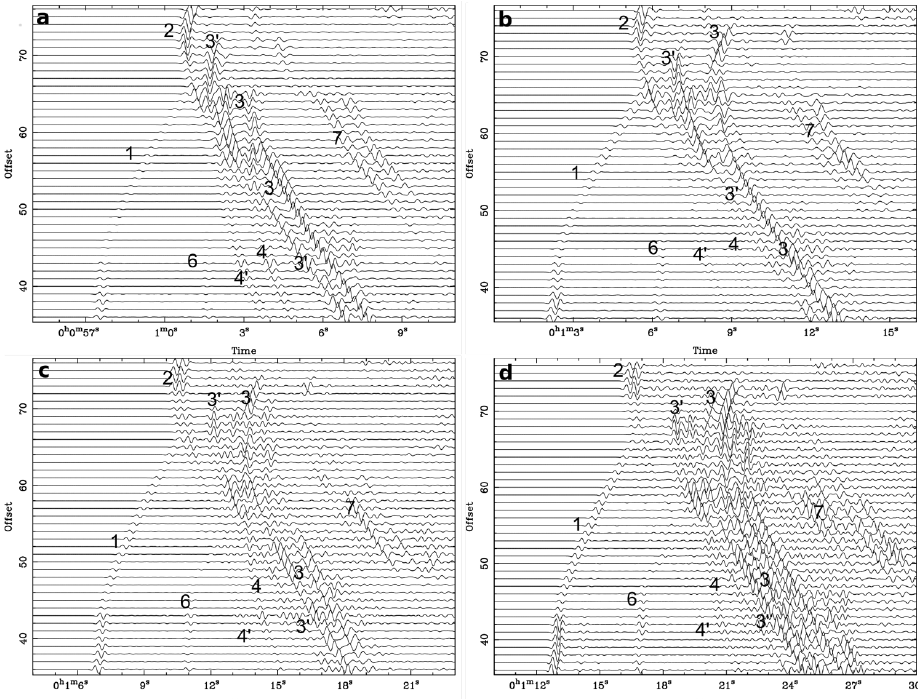
Fig. 11: Time-reduced synthetic record section for the model with DSC for different source depths inside the oceanic crust. Depths: (a) 88 km, (b) 108 km, (c) 128 km, (d) 155 km. The additional phase 3 0 is present for all depths. Note the increasing length of the guided wave train with increasing source depth.